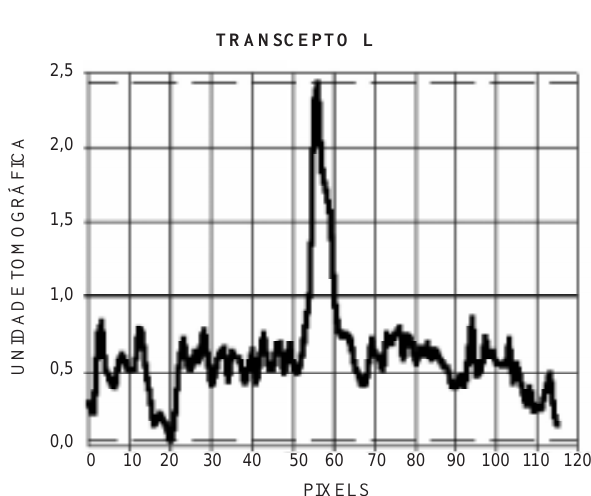
Figura 10. Variação das unidades tomográficas ao longo do transcepto L da microtomografia da figura 7.